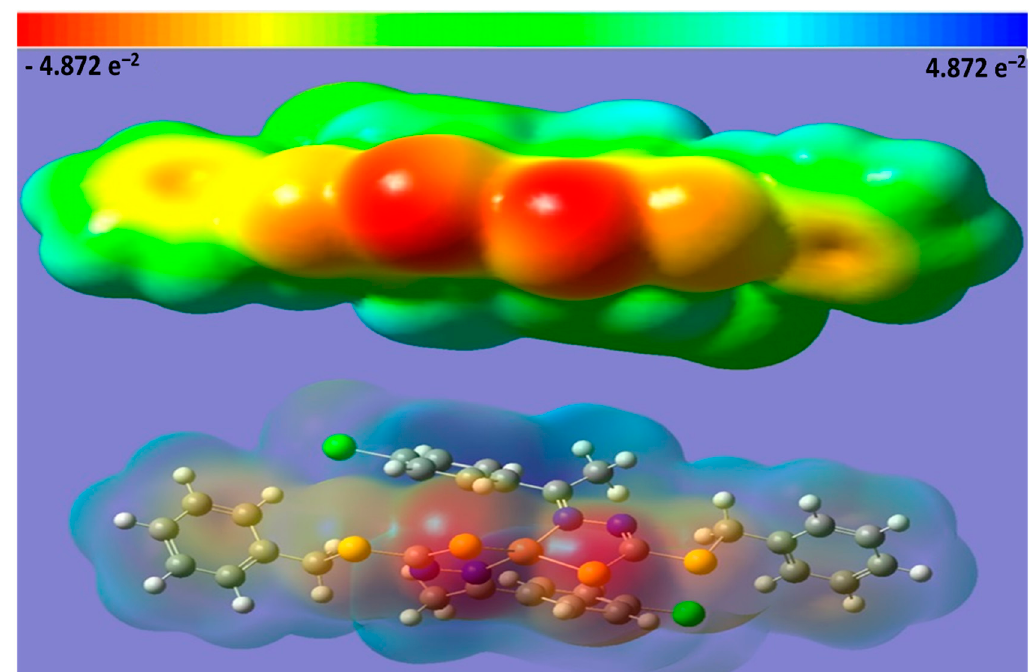
Figure 8. Molecular electrostatic potential (MEP) of the cis-Cu(II) complex.